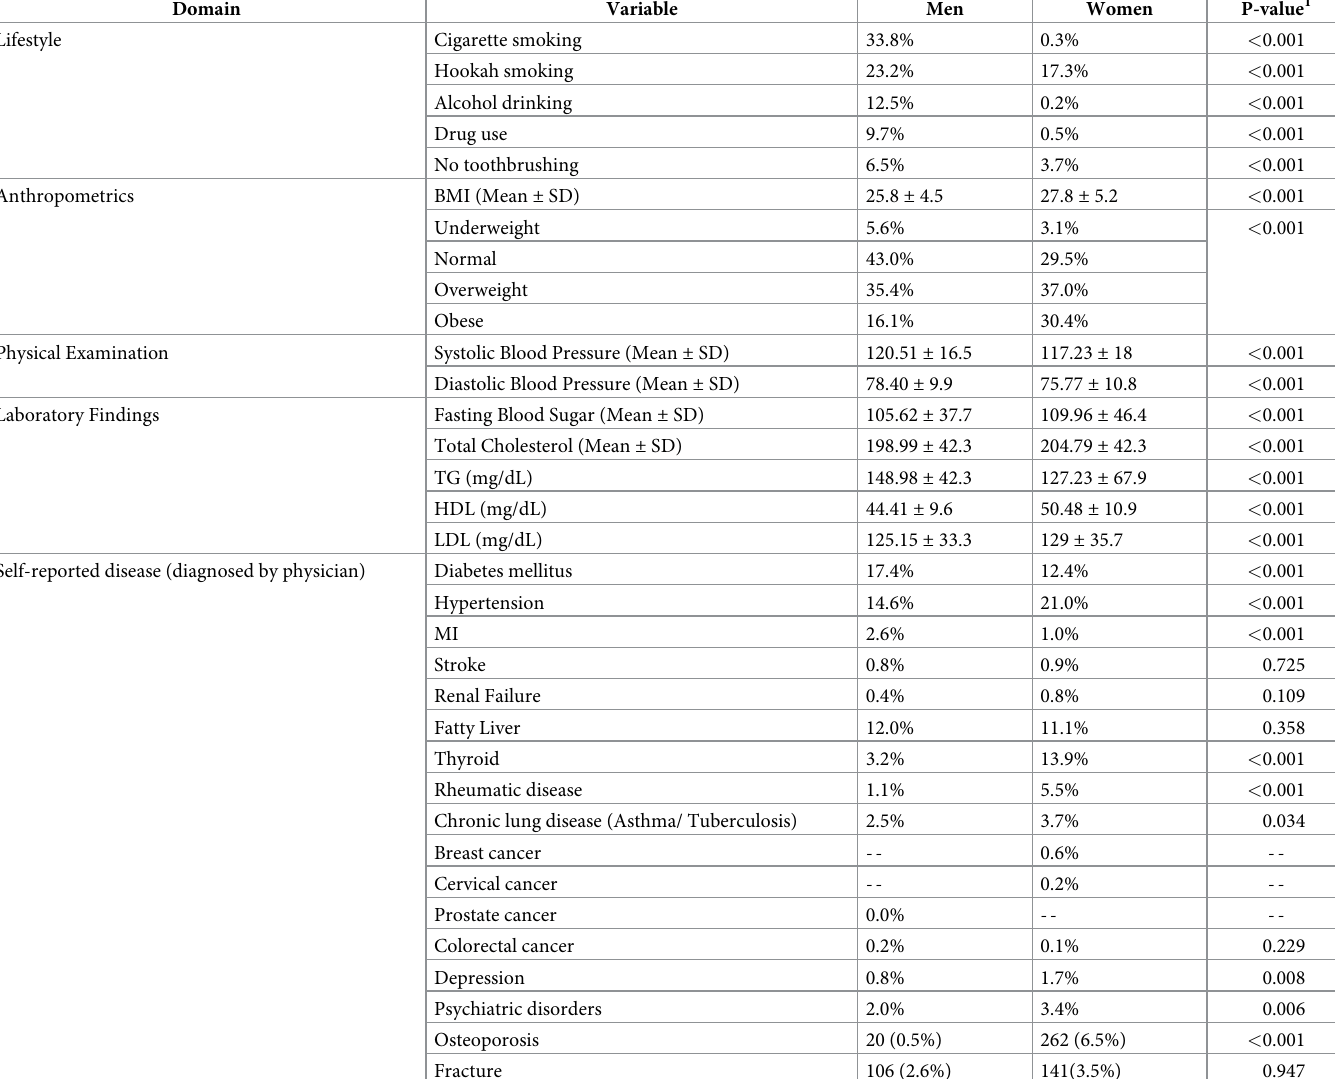
Table 6. Participants’ baseline characteristics by gender and prevalence of self-reported health